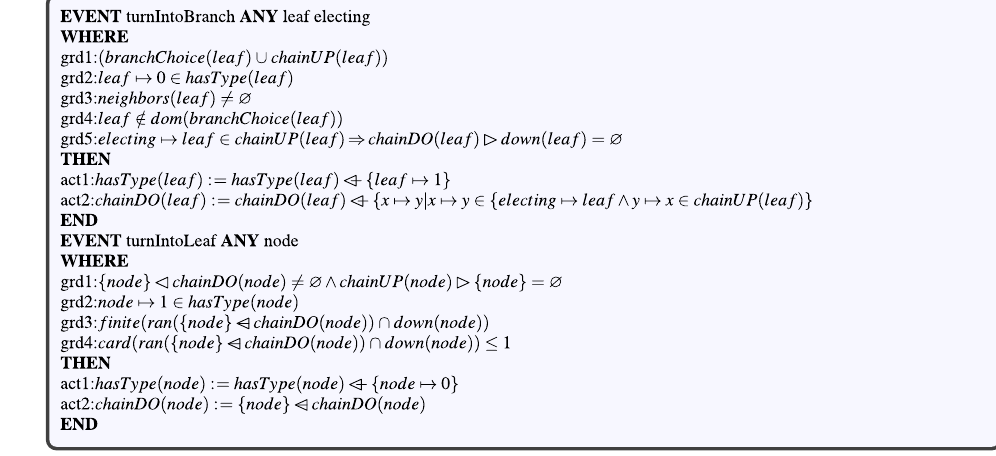
Figure 11. Node type update events.